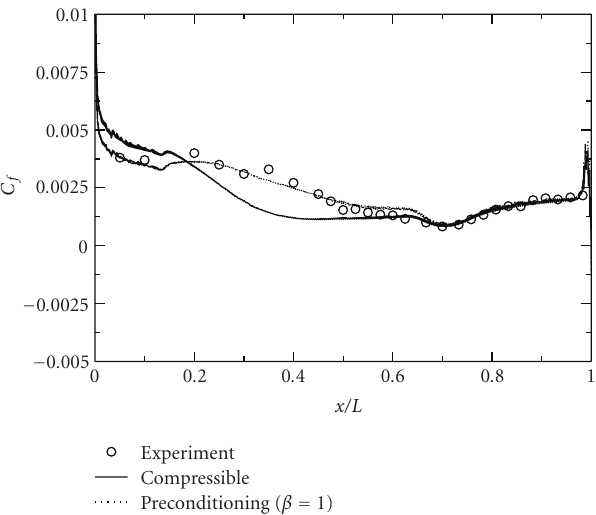
Figure 18: Comparison of predicted and measured C f distribu-